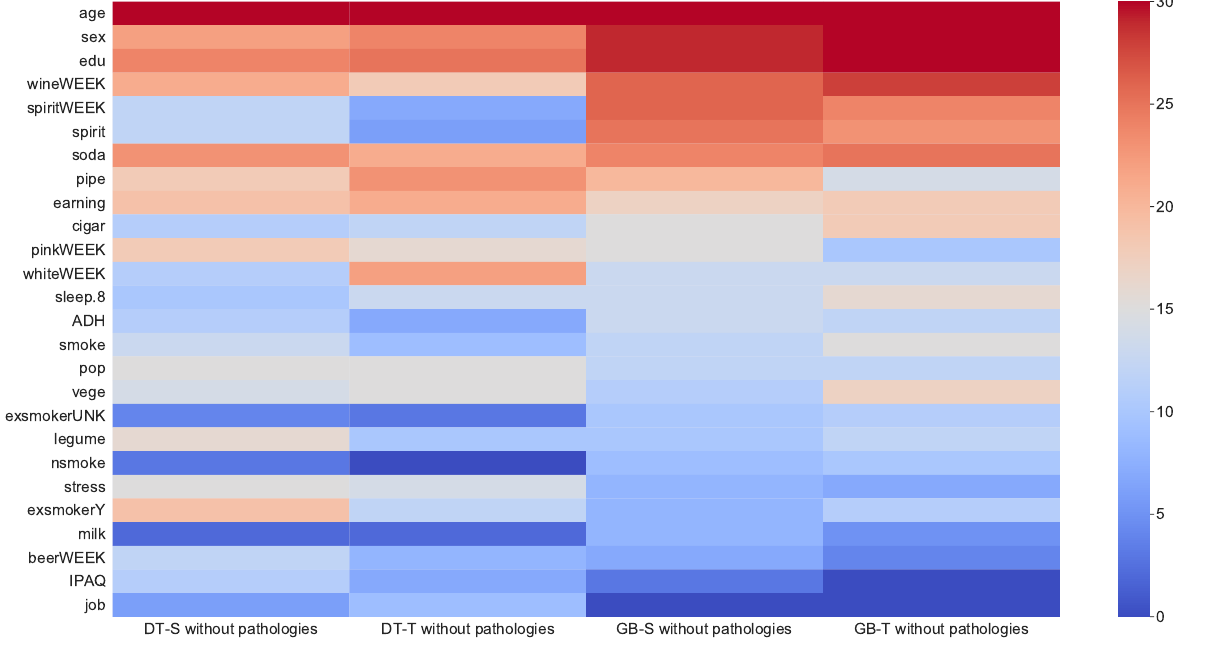
Figure 11. Heat map representation of the frequency of different variables obtained using FS with GA, dataset without